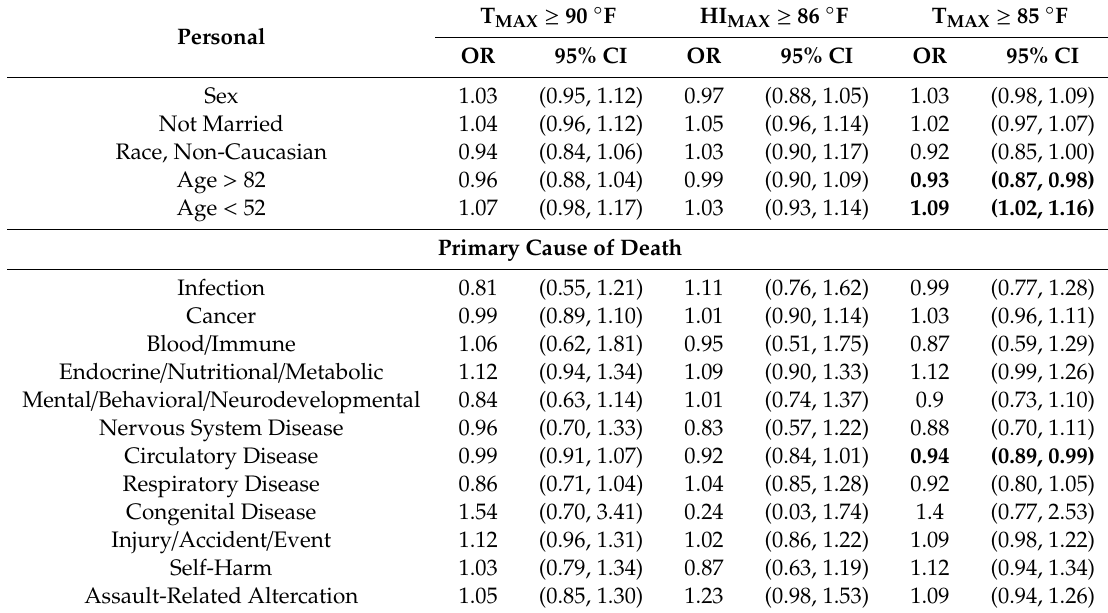
Table 3. The relative odds ratio (OR) of dying outside of the home during extreme heat, during the warm season for those who had the following characteristic (Personal, Primary Cause of Death) or who lived in a census tract with the characteristic (Social, Environmental), compared with those who did not have that characteristic, Boston, 2000–2015. Individuals were considered to either have a personal modifier or be dying from that specified primary cause of death, or not. Bold indicates that the OR is significant at p <